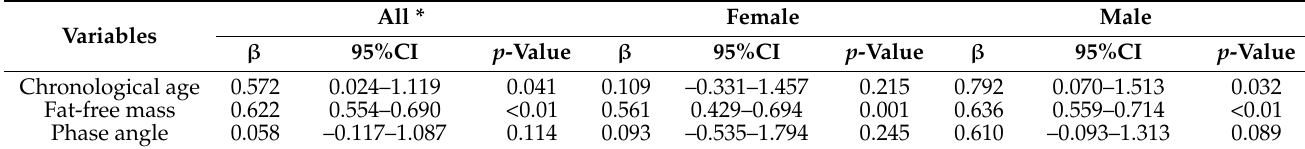
Table 3. Handgrip strength independent predictive variables in adolescent